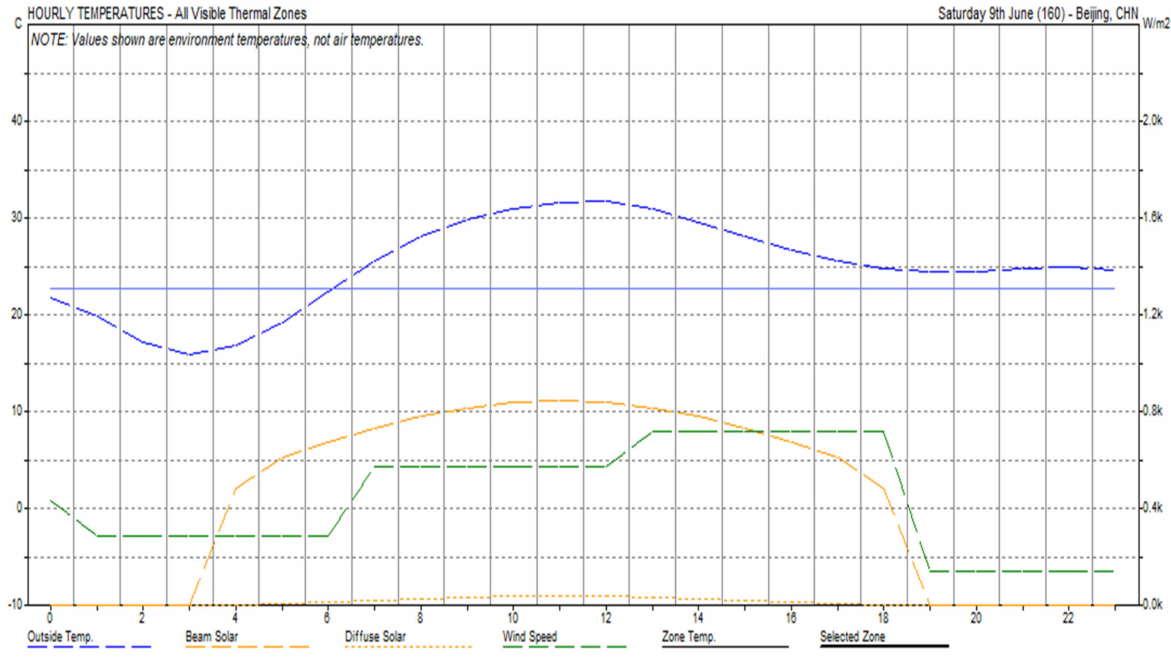
Figure 24. Hourly temperature